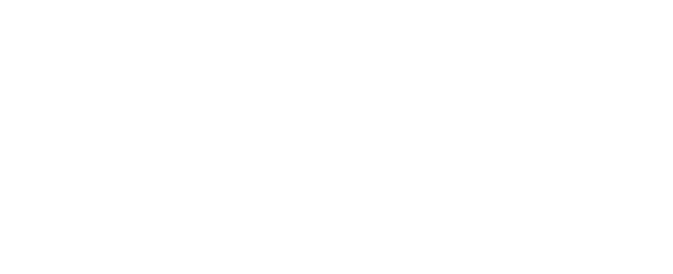
Table 2. Table of hyperparameters used to implement the transfer